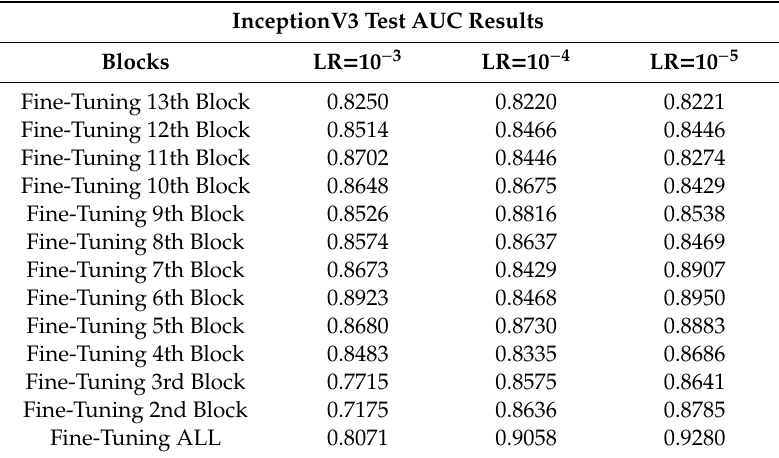
Table 4. Results of the InceptionV3 architecture.